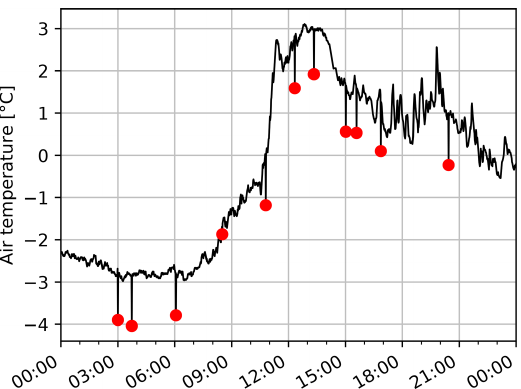
Figure 2. Air temperature data at station 6 on 7 December 2019, showing unnatural spikes. Data points that are flagged by the tem- perature spike check are marked by red